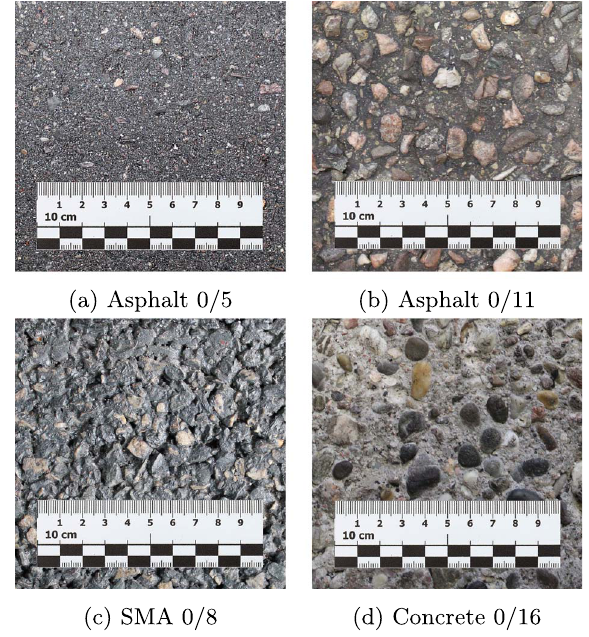
Figure 3. Selected road surfaces for this